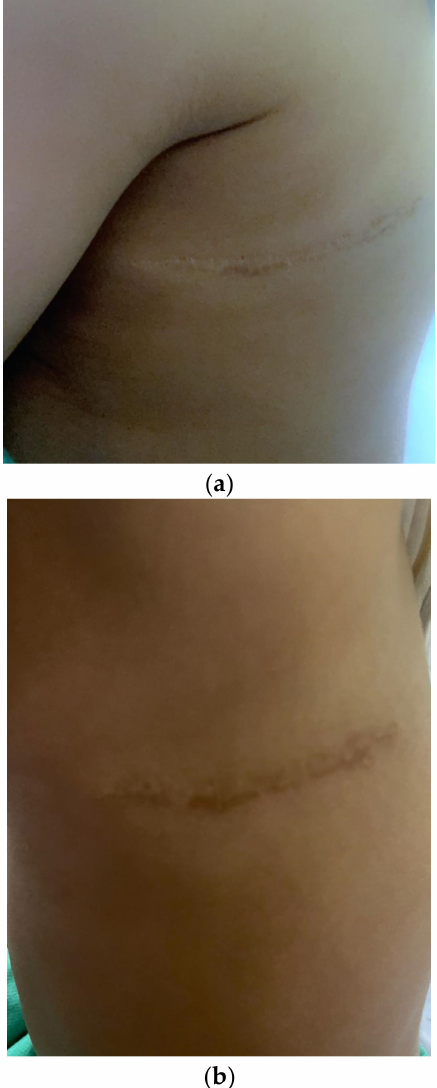
Figure 4. ( a , b ): Incision scar with no local recurrence after